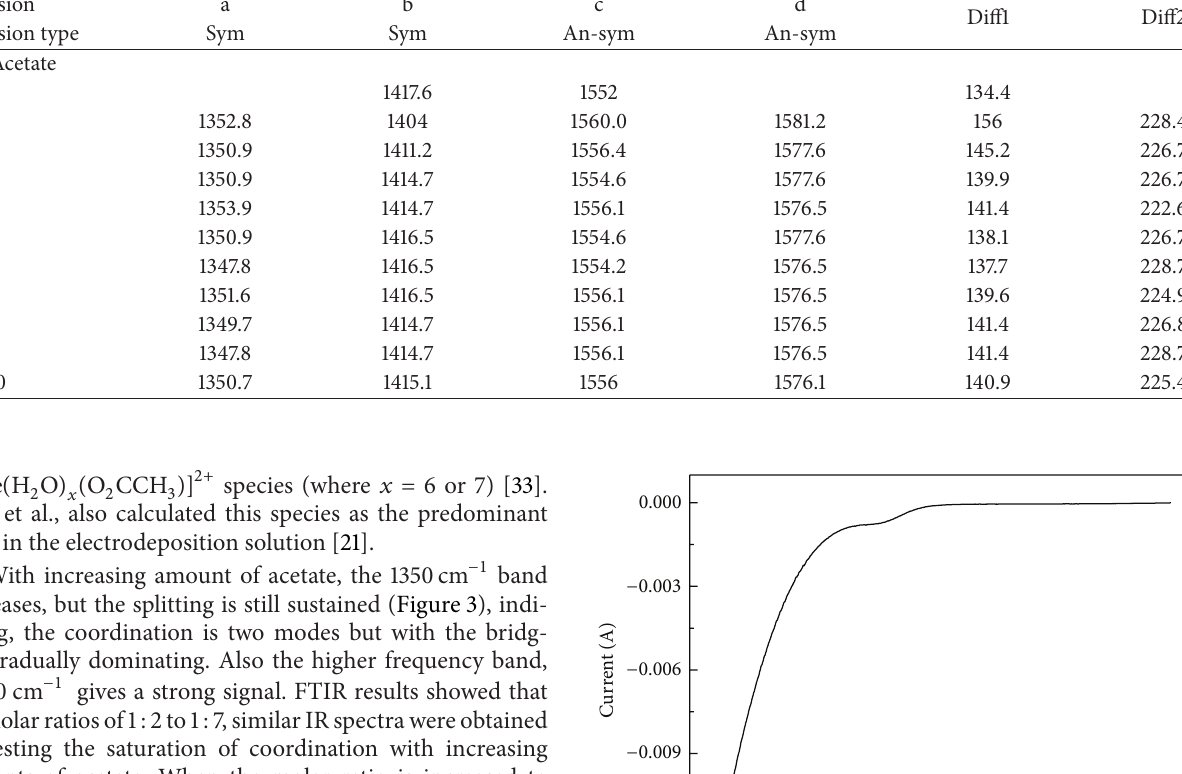
Table 1: IR assignment for Ce(III)-acetate complex and calculation of frequency difference (peak position in cm − 1 ) according to Figure 3. Emission